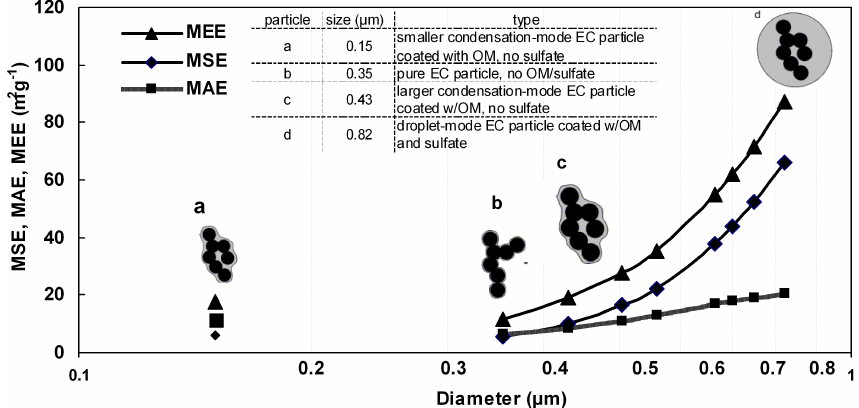
Fig. 3. EC-normalized mass scattering efficiency (MSE), mass absorption efficiency (MAE) and mass extinction efficiency (MEE) of four types of EC-containing particles, taking chemical composition of the HKUST sample collected on 5–6 February 2008 as